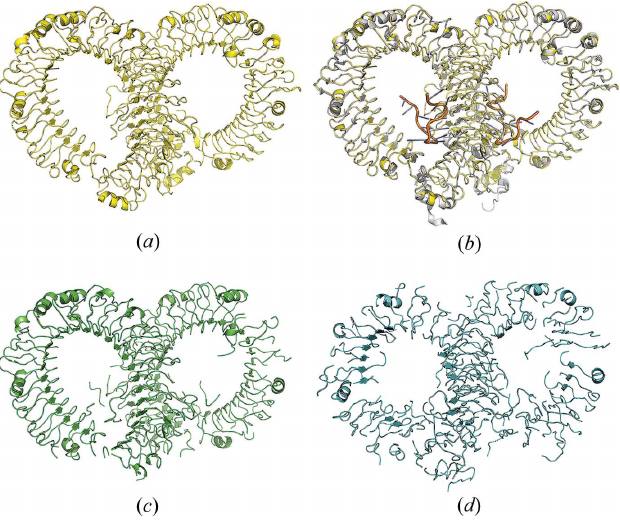
Figure 6 Method comparison, case study 4. ( a ) Model from IPCAS ; ( b ) model from IPCAS superimposed with the crystal structure (PDB entry 4z0c); ( c ) model from Phenix.AutoBuild ; ( d ) model from Buccaneer